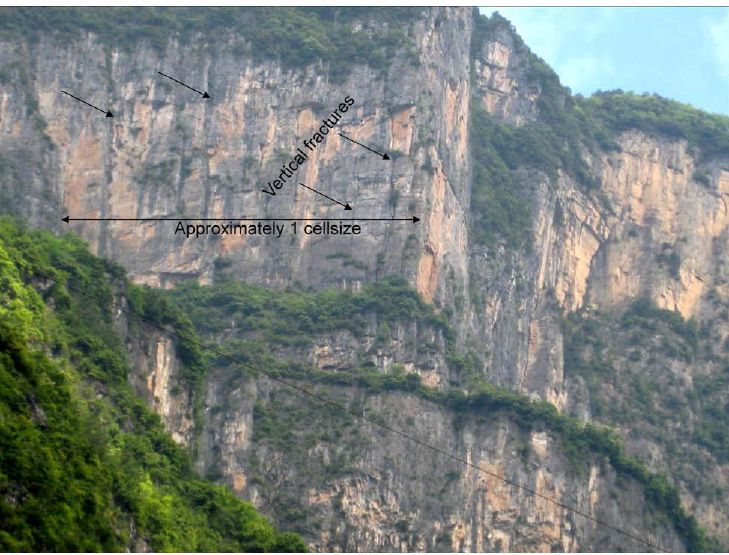
Figure 2—Persuasive large-scale vertical fractures on equivalent